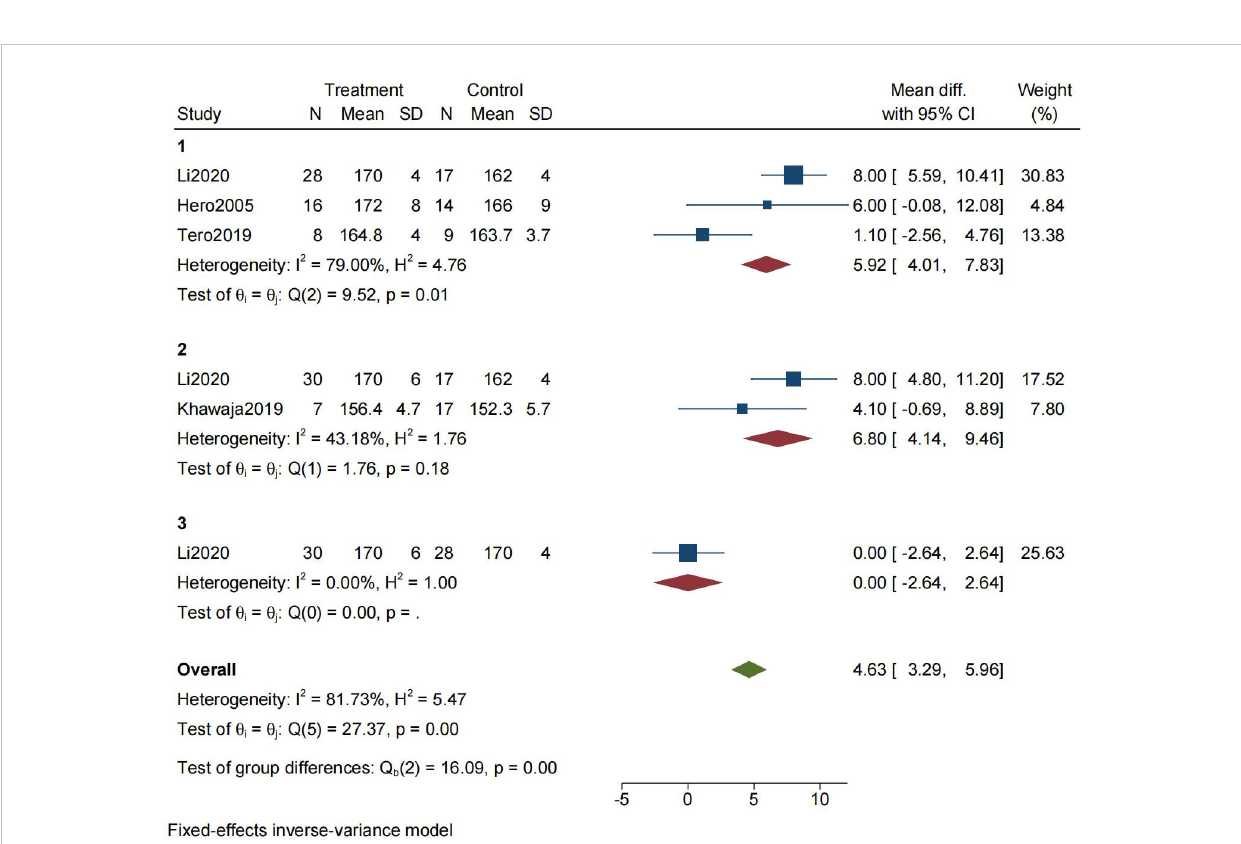
FIGURE 4 Forest plot for the meta-analysis of fi nal height (1=AI vs No treatment, 2=GnRHa vs No treatment, 3=GnRHa vs AI).